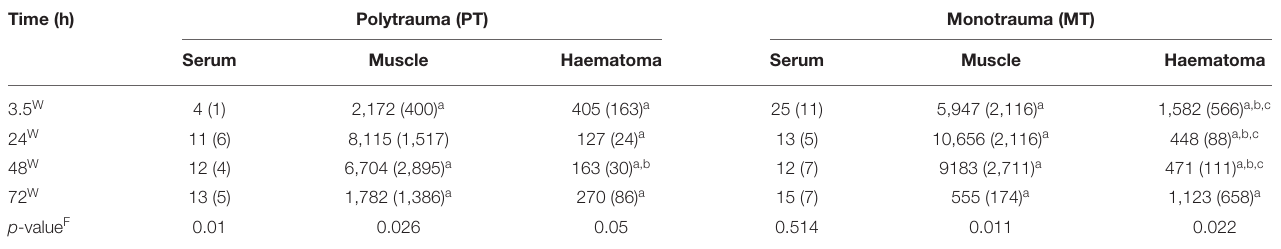
TABLE 2 | Systemic and local concentrations of IL-8 pg/ml; a p < 0.05 compared to serum concentrations, b p < 0.05 compared to muscle concentrations, c p < 0.05 compared to PT. Time (h)